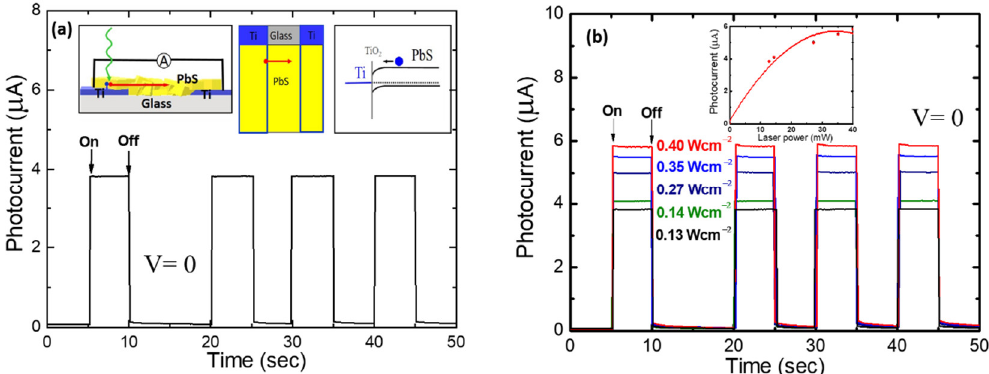
Figure 3. ( a ) Transient photocurrent characteristics of a lateral Ti/PbS/Ti photovoltaic device under the light excitation from a frequency doubled DSPP 532 nm laser. Schematics of the devices are included; the blue and red dots represent photo-electrons and photo-holes, respectively. The potential energy diagram of PbS and Ti Schottky junction is also shown. ( b ) Photocurrent transients for various excitation power densities. The inset shows the photocurrent saturation with respect to the excitation power.